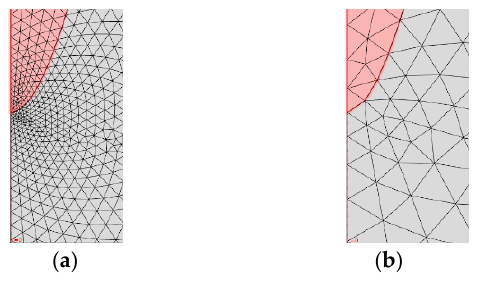
Figure 2. Meshing of needle electrode in field simulation. ( a ) manually with finer mesh than the finest automatic meshing; ( b ) automatic with “extra fine” mesh.